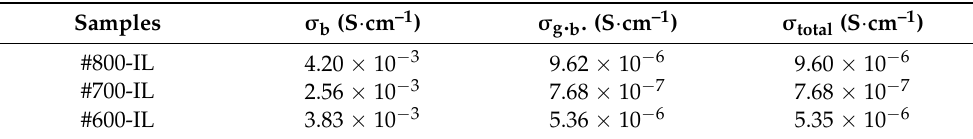
Table 2. Bulk ionic conductivities ( σ bulk ), grain boundary conductivities ( σ gb ), and total ionic conductivities ( σ total ) of the In-doped LLZO–LZO thin film with different annealing temperature at